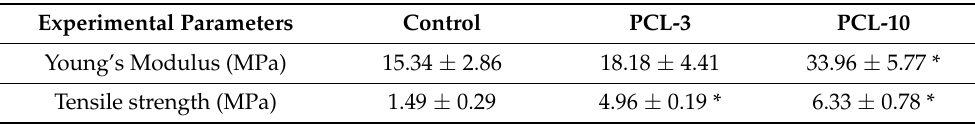
Table 2. Tension test results of control, PCL-3, and PCL-10 cloth. The data are presented as mean ± standard of error for sample size, n = 5. In the figure, * refers p < 0.05 compared to control. Experimental